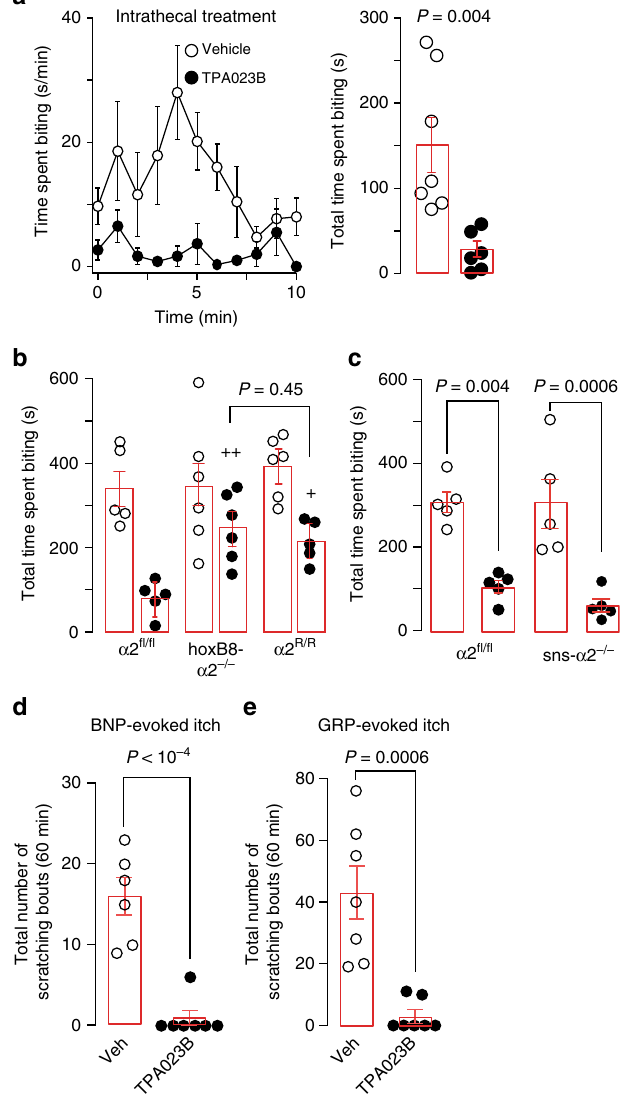
wide-spread, almost ubiquitous, expression of GABA A Rs in the CNS, such new opportunities should not come as a surprise.